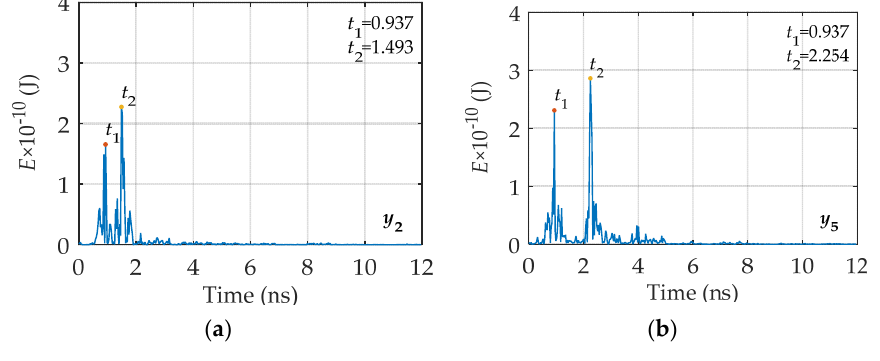
Figure 13. TEDAWT curves of single-channel signals on the longitudinal survey line x 2 : ( a ) x 2 − 1 represents the signal of the 5 cm model box; ( b ) x 2 − 2 represents the signal of the 10 cm model box; ( c ) x 2 − 3 represents the signal of the 15 cm model box; ( d ) x 2 − 4 represents the signal of the 20 cm model box.